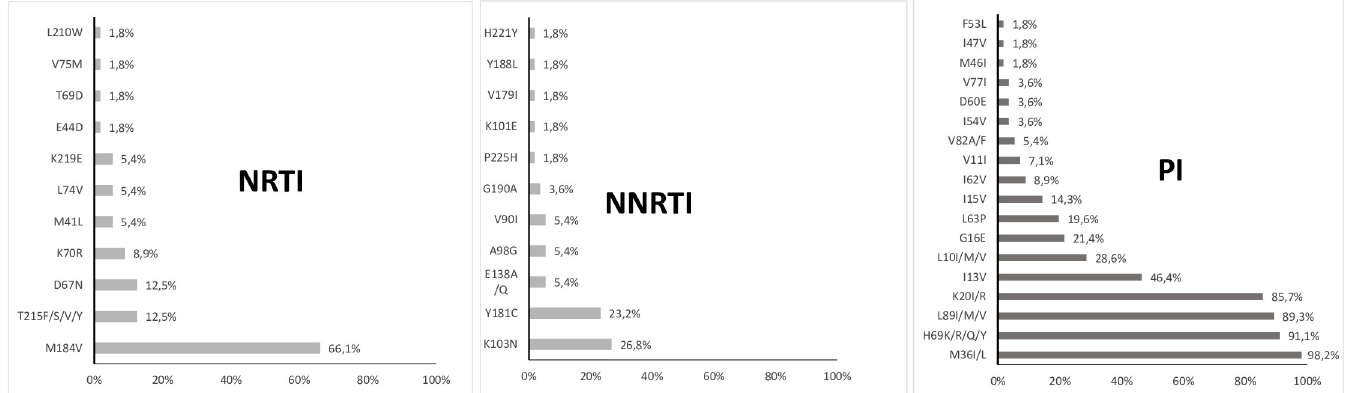
Fig 1. Drug resistance mutations detected in HIV-1 strains among children with virological failure. Drug resistance mutations are presented by increasing order of expression level. Mutations for different drug classes are indicated: NRTI (nucleoside reverse transcriptase inhibitors); NNRTI (non-nucleoside reverse transcriptase inhibitors); PI (protease inhibitors). V11I, K20I/R, M36I/L, H69K/R/Q/Y and L89I/M/V are considered polymorphic mutations present in vast majority of HIV-1 non-B subtypes.